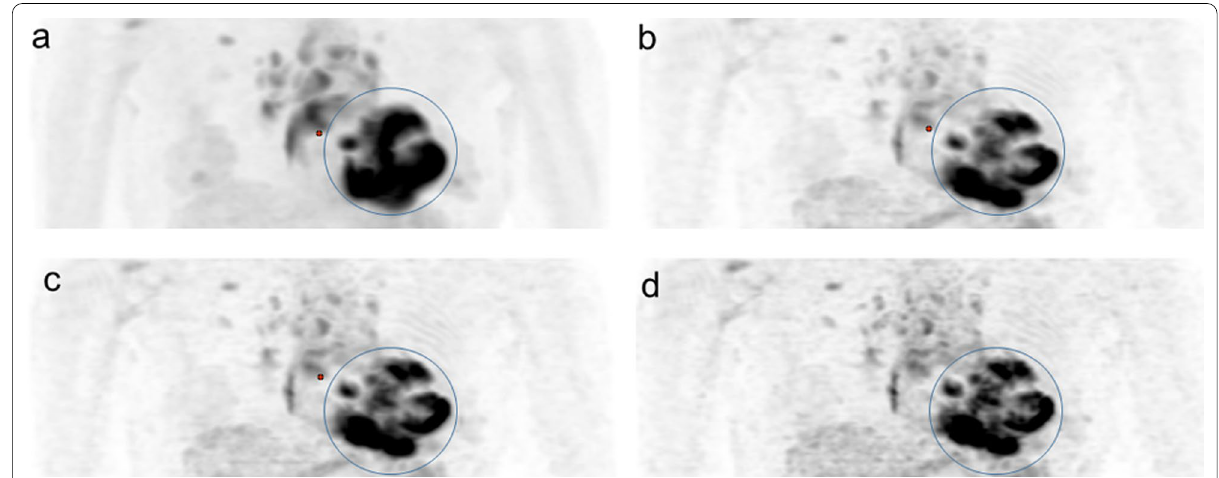
Fig. 2 A 72-year-old female patient with cardiac sarcoidosis before treatment. The individual patient-based Ki image ( a ) and three population-based Ki images [Ki-1000 image ( b ), Ki-700 image ( c ), and Ki-350 image ( d )] all had a visual score of 3 in the myocardium